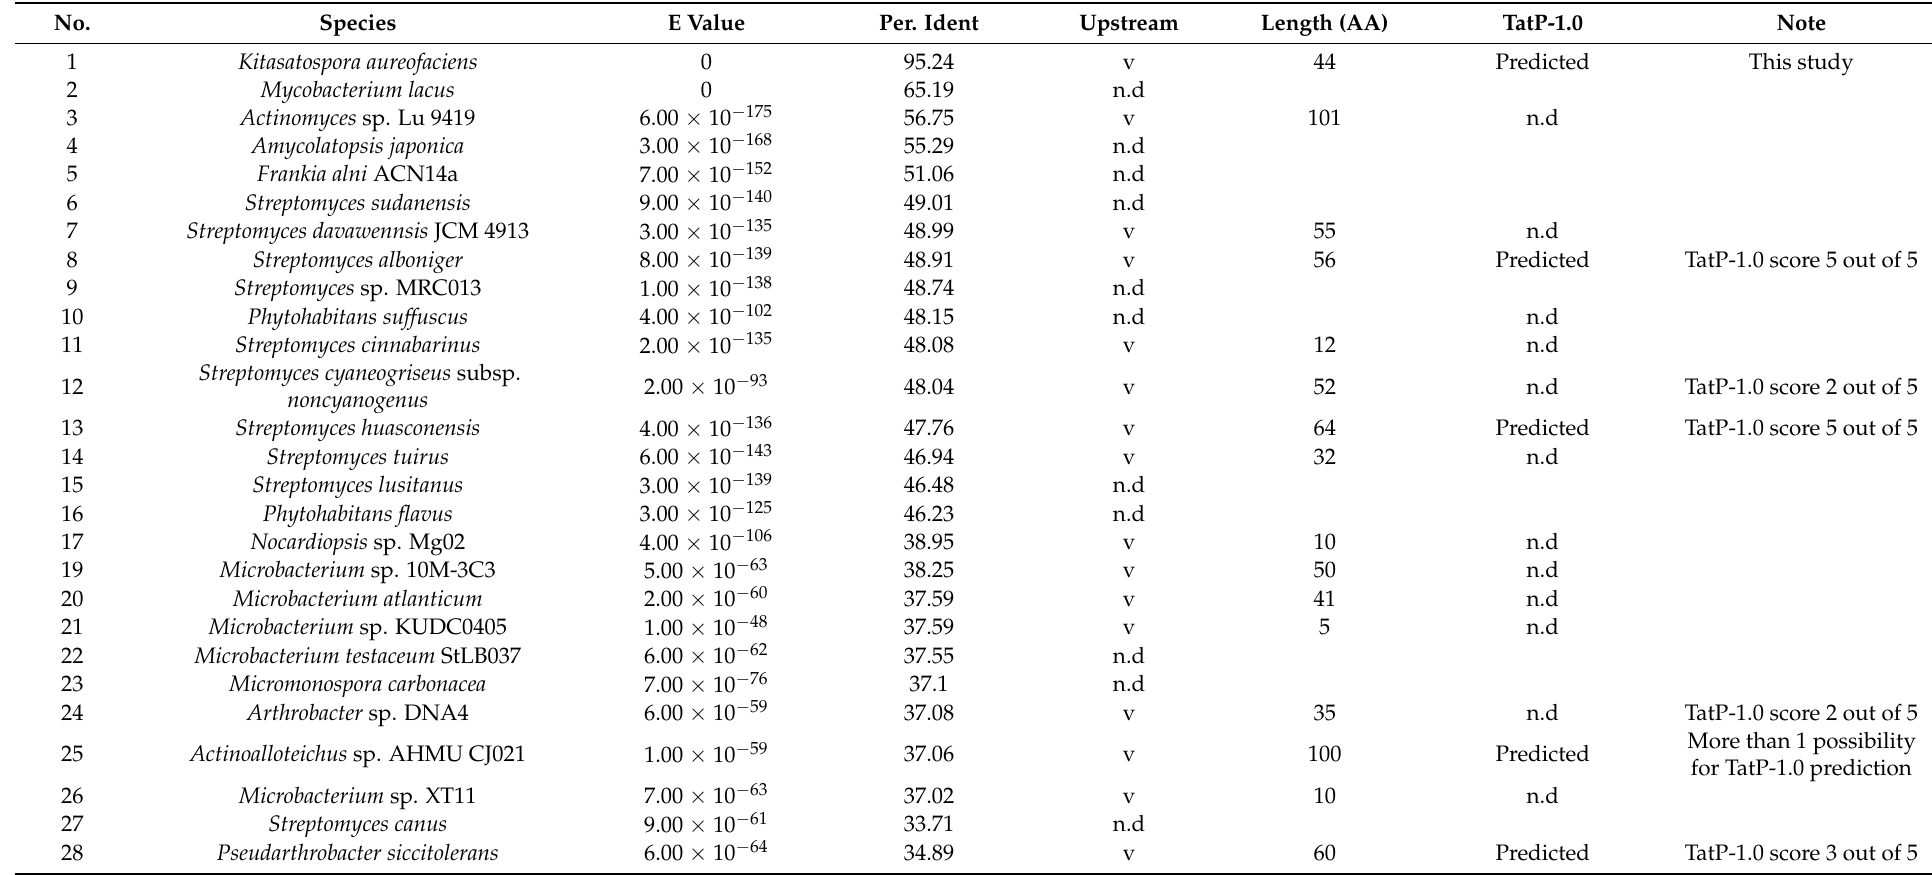
Table 1. Prediction of putative Tat signal peptide using